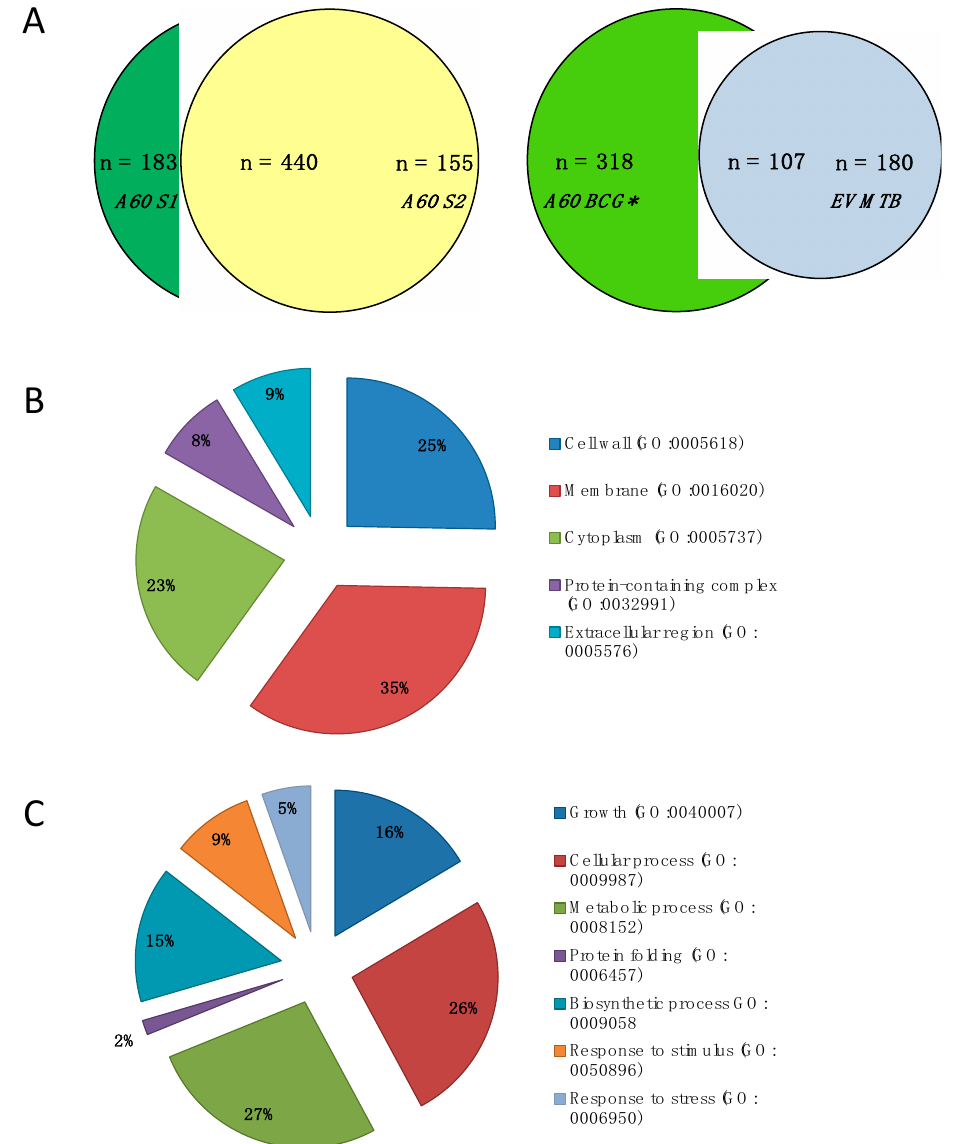
Figure 1. ( A ) Venn diagram of proteins identified using two samples of A60 as well as comparison of A60 of M.bovis Bacillus Calmette-Guérin (A60 BCG) and extracellular vesicles of M. tuberculosis (EV MTB) proteins. Pie charts show protein distribution based on ( B ) cellular component and ( C ) biological process based on Gene Ontology (GO) term functional enrichment on STRING analysis. *A60 BCG refers to the 426 shared proteins of A60 S1 and S2, with matches in MTB H37Rv Uniprot database.